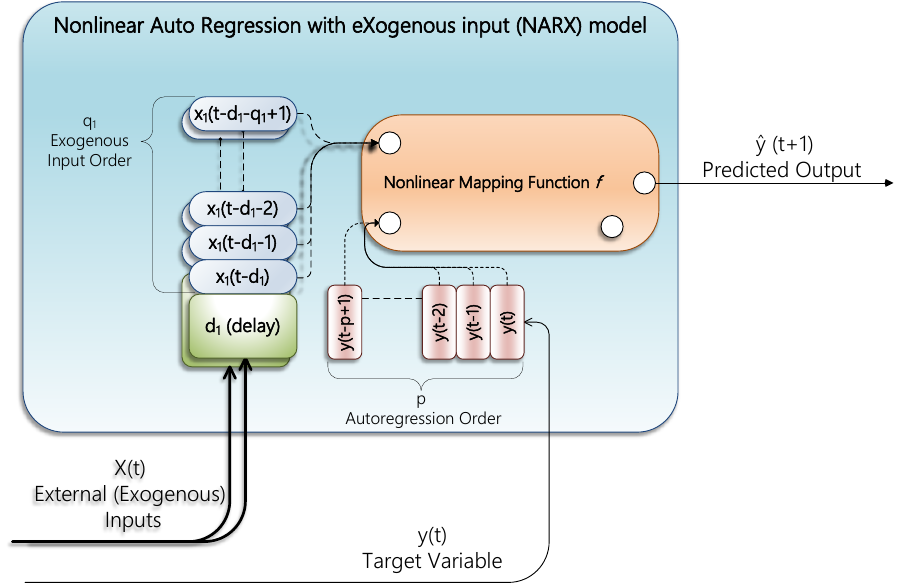
Figure 1. NARX model.